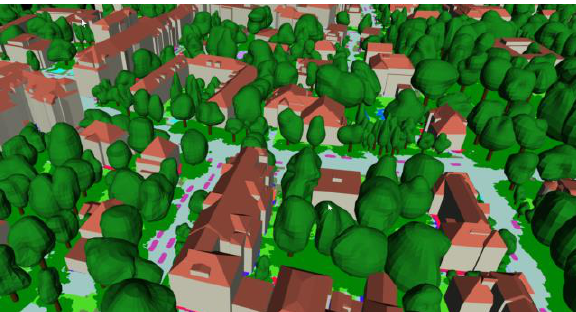
Figure 7: Land cover information combined with automatically derived LoD2 building models and 3D single tree information including position, height and diameter